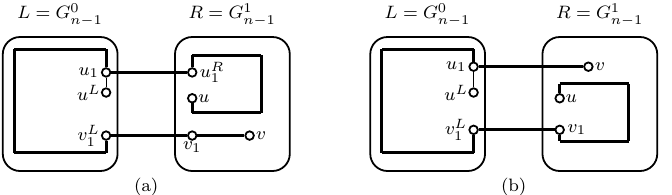
= v in Case 2.1.3.1; ( b ) Illustration of proof of u R 1 (cid:54)